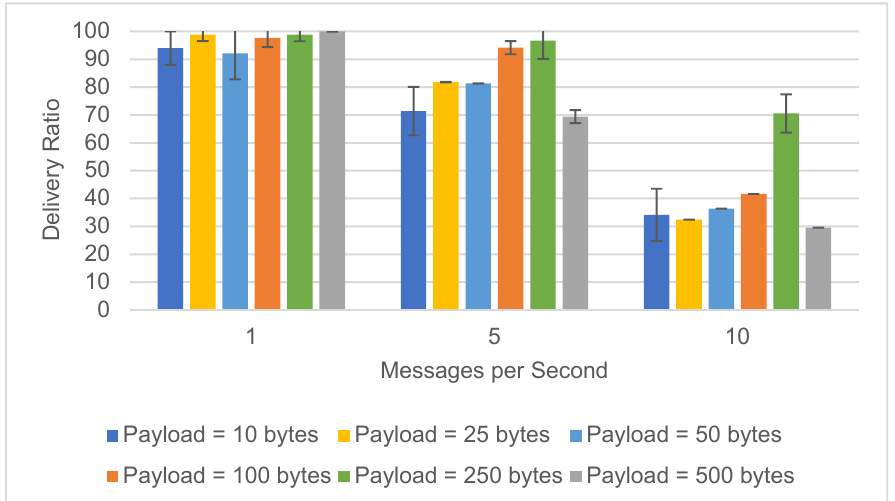
Figure 12. Delivery ratio (%) of messages (1 sensor and 1 destination).